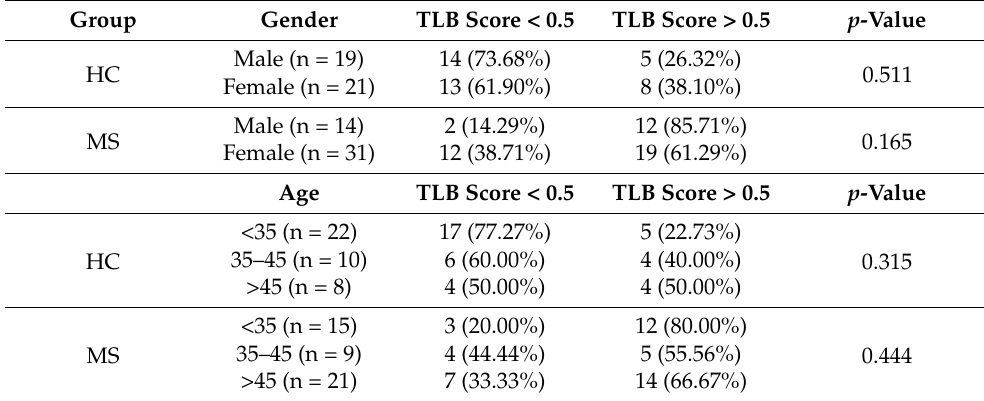
Figure 7. Distribution of the probability score (TLB score) within healthy individuals (HC group, black) and multiple sclerosis patients (MS group, red) according to gender ( left ) and age ( right ). The p -value (t-Student and ANOVA test in HC group; Wilcoxon test and Kruskal – Wallis test in MS group) indicates there is no statistically significant difference between subcategories (gender and age) within HC and MS groups ( p -value > 0.05). Table 3. Contingency table for gender and age for model 3.